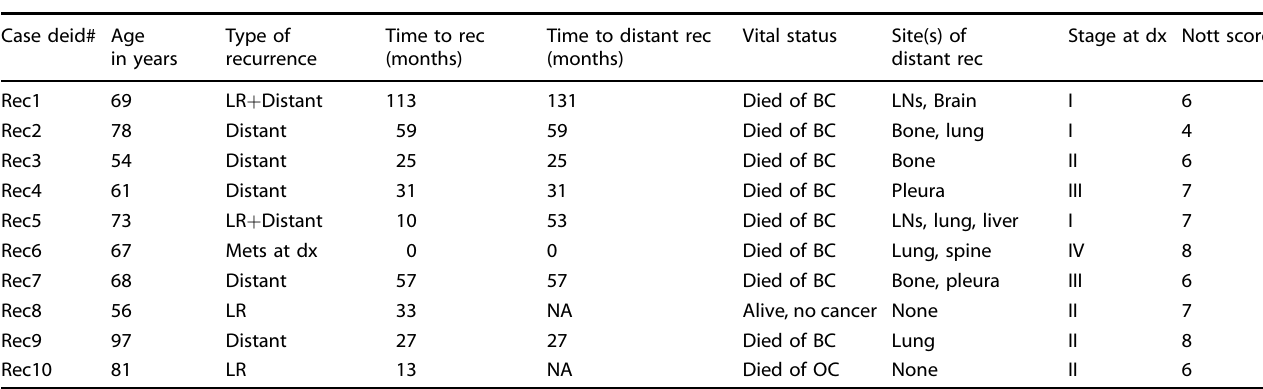
Table 3. Clinical features of cases that